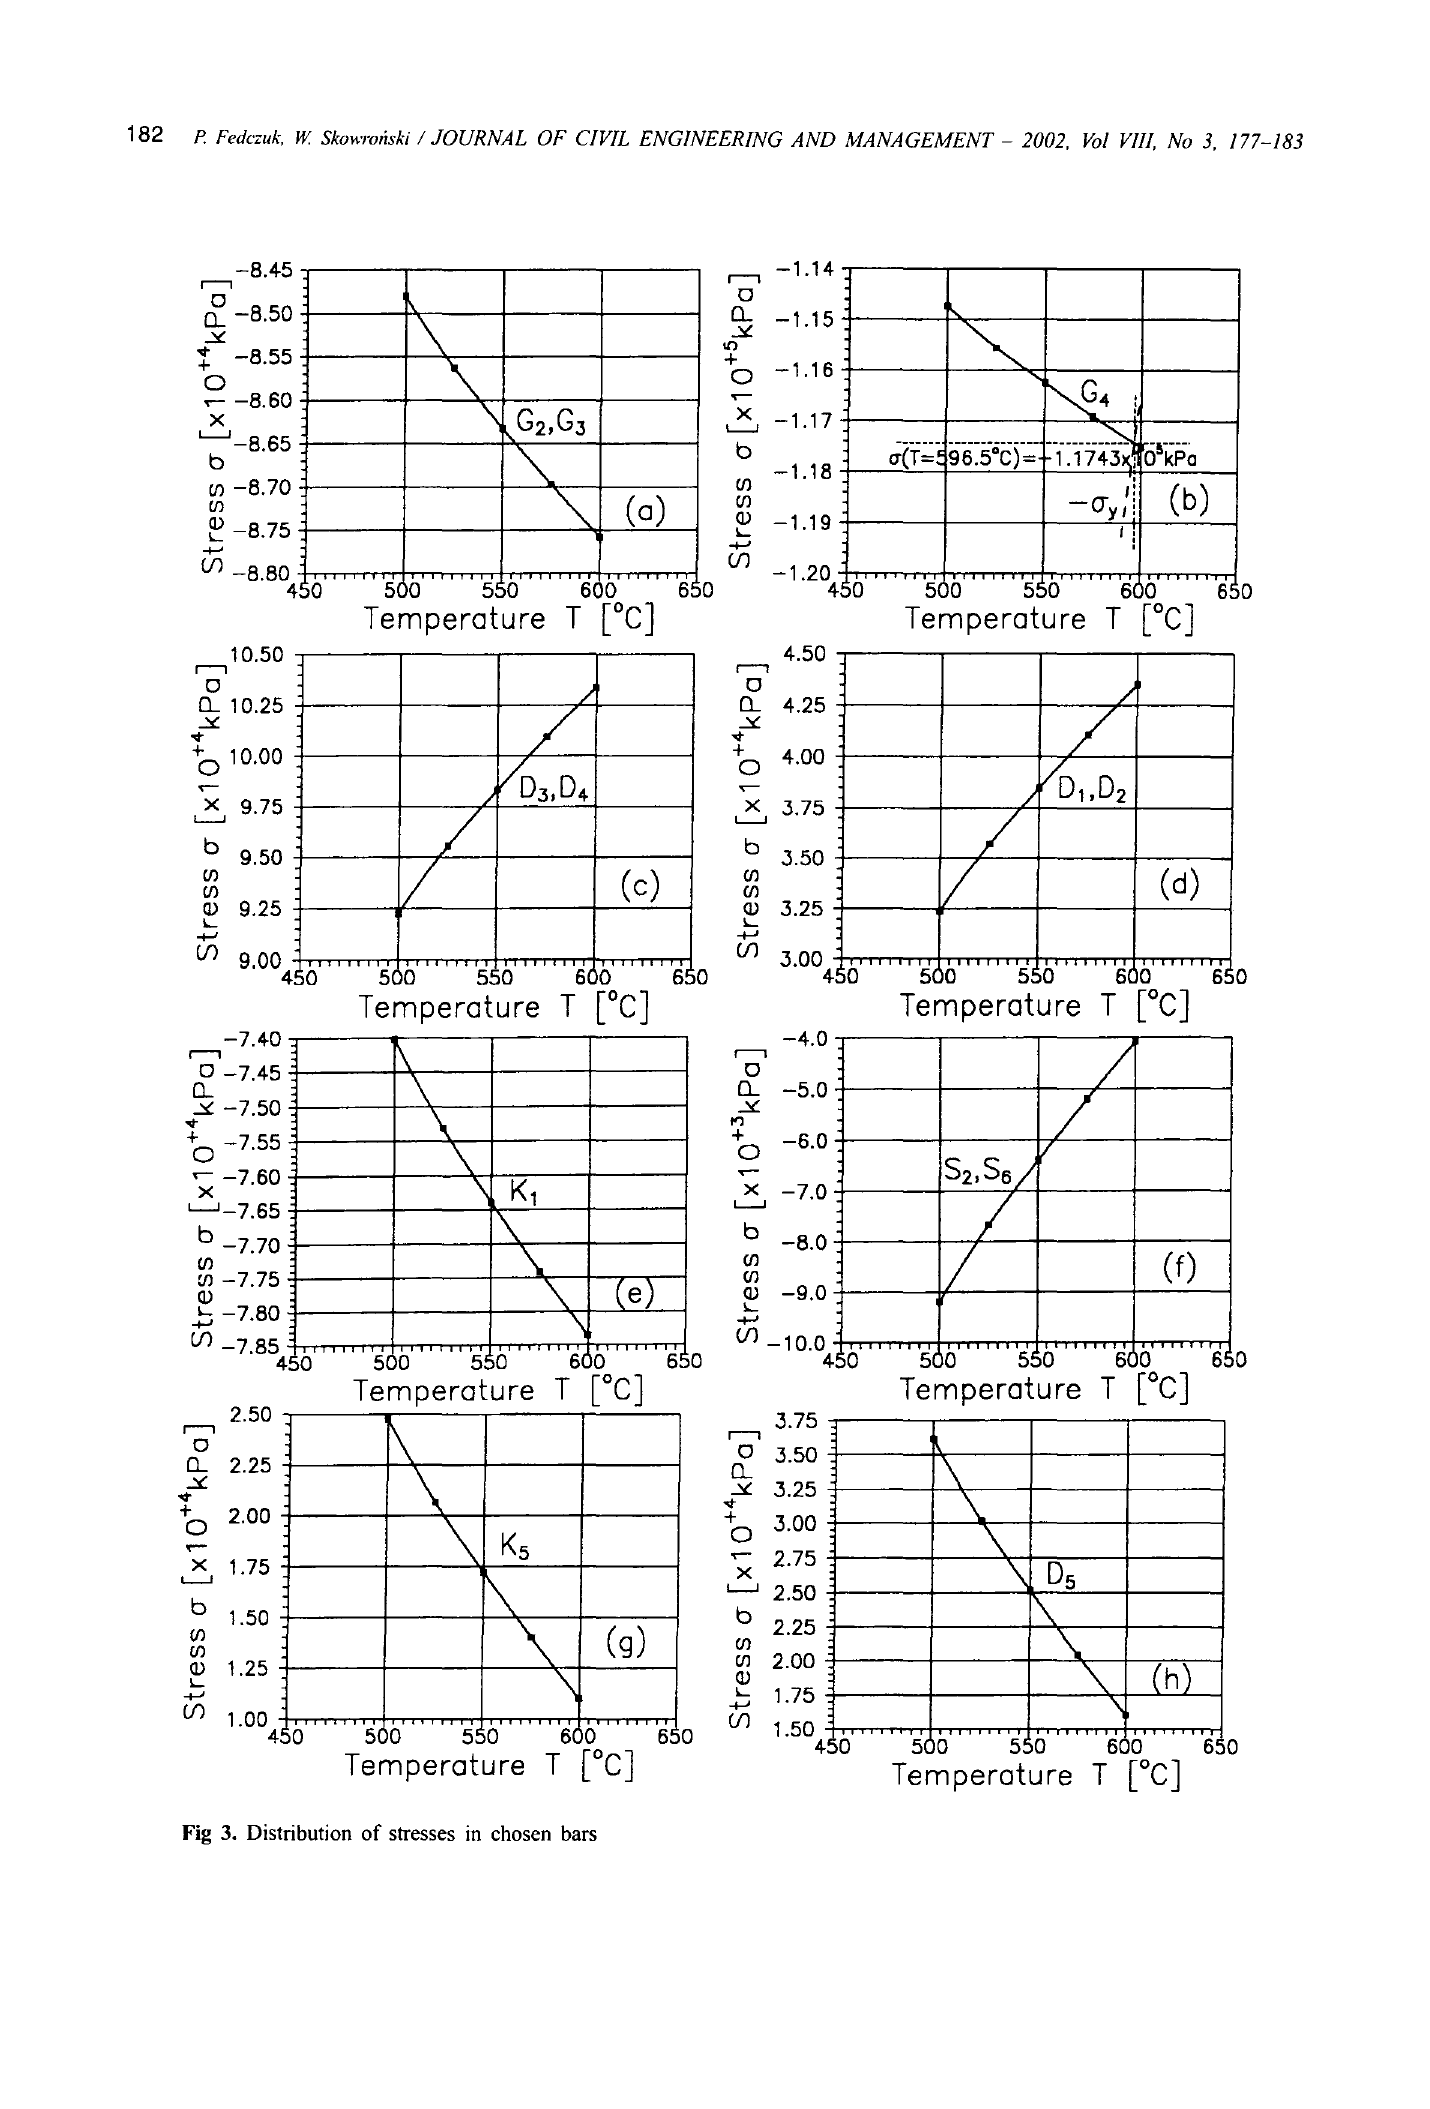
Fig 3. Distribution of stresses in chosen